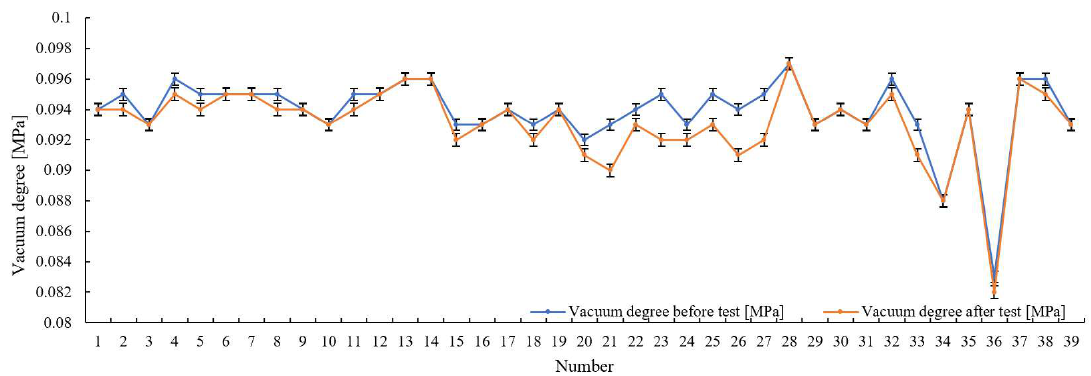
Figure 10. Vacuum degree of the grease suction and drainer devices before and after 12,000 fatigue tests.